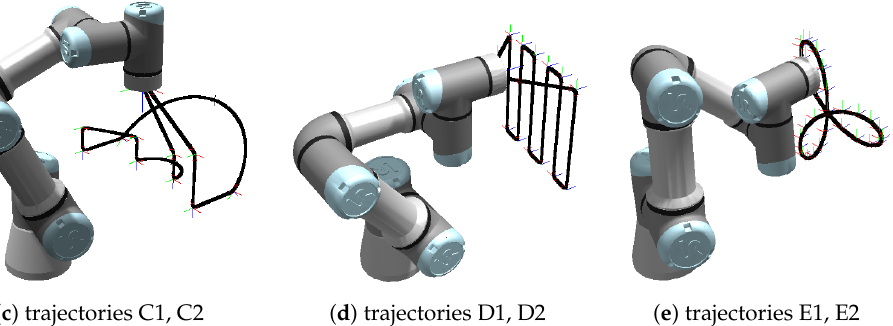
Figure 3. Visualization of the five testing robot end-point paths; the UR3 robot is shown as a scale